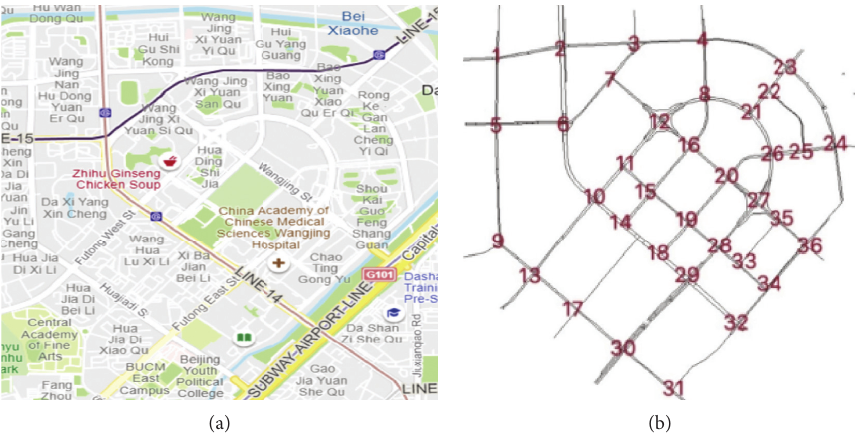
Figure 1: Wangjing area map: (a) area road map; (b) area road network